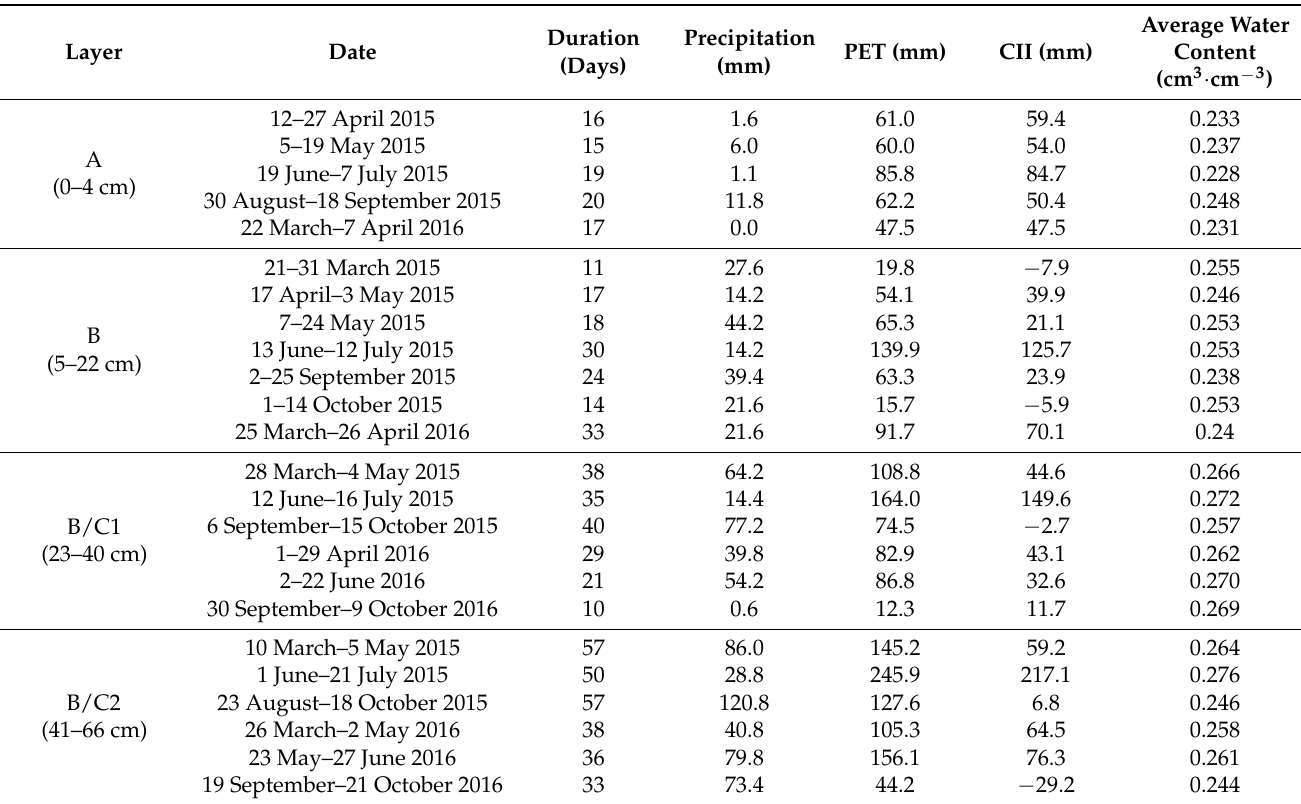
Table 6. Summary of the occurrences of days with water contents under the PDA